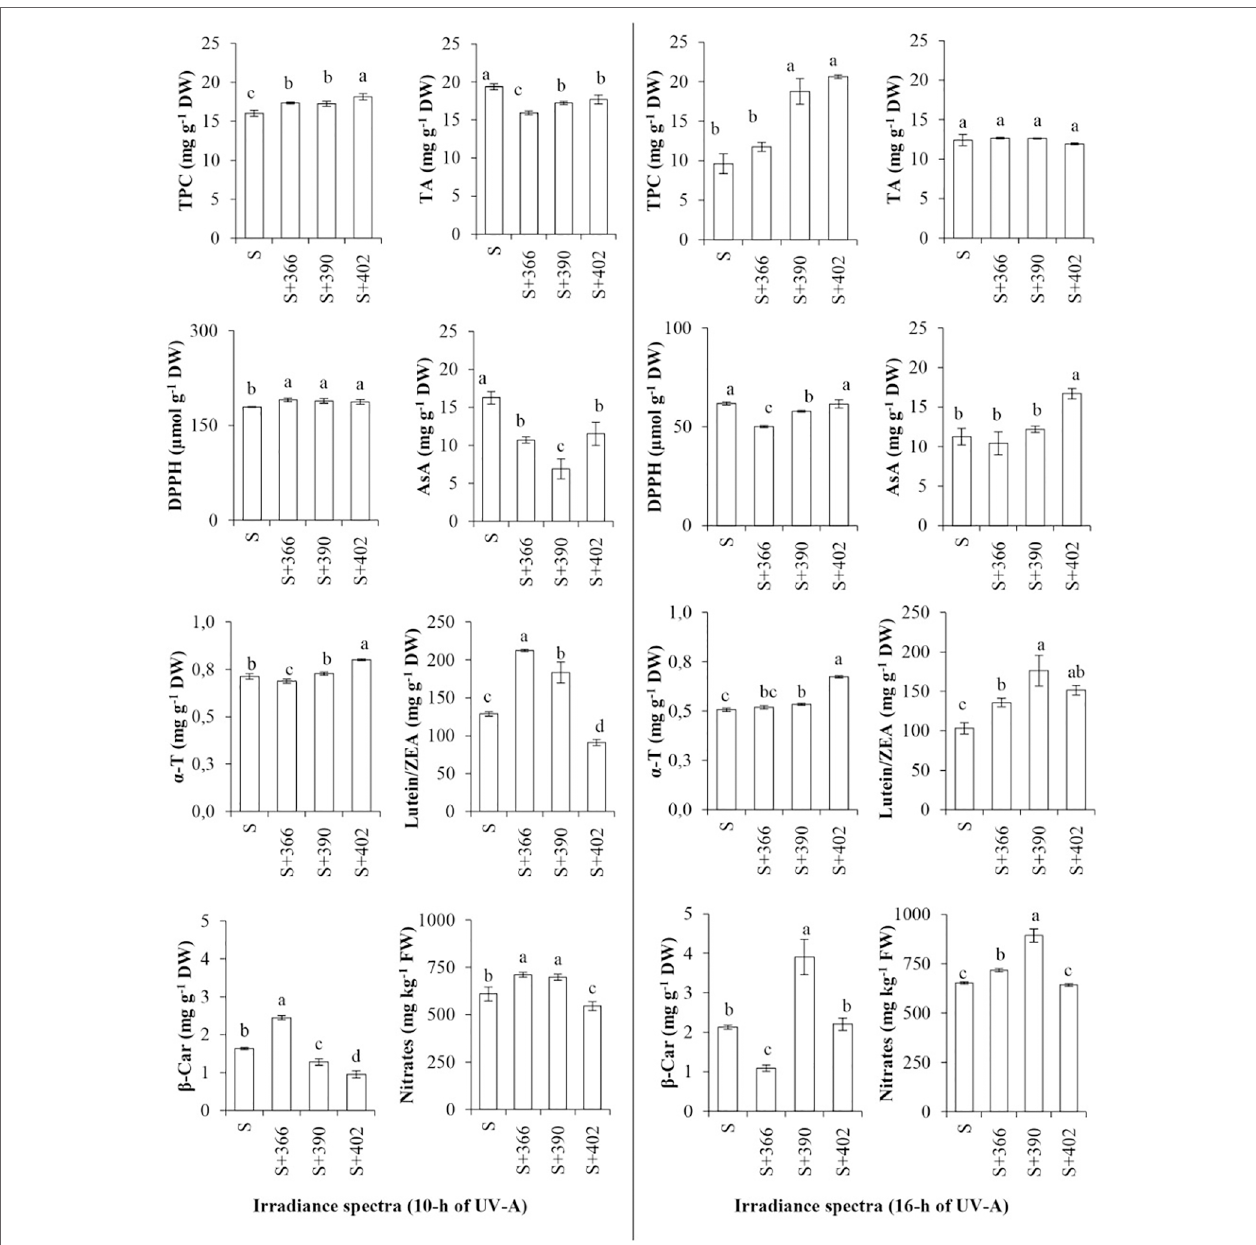
FIGURE 3 | The effect of supplemental UV-A LED radiation on nutritional quality characteristics of mustard microgreens. TP, total phenols; TA, total anthocyanins; DPPH, DPPH• radical-scavenging activity; AA, ascorbic acids; α -T, α -tocopherol; L/Z, lutein/zeaxanthin; BC, β -carotene; NO 3 , nitrates; S, standard irradiance. Different letter(s) indicates a significant difference at P ≤ 0.05 by the Duncan’s Multiple Range